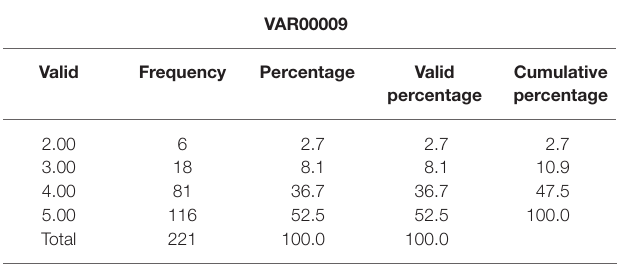
TABLE 11 | Positive aspects regarding the use of comics as a resource for learning